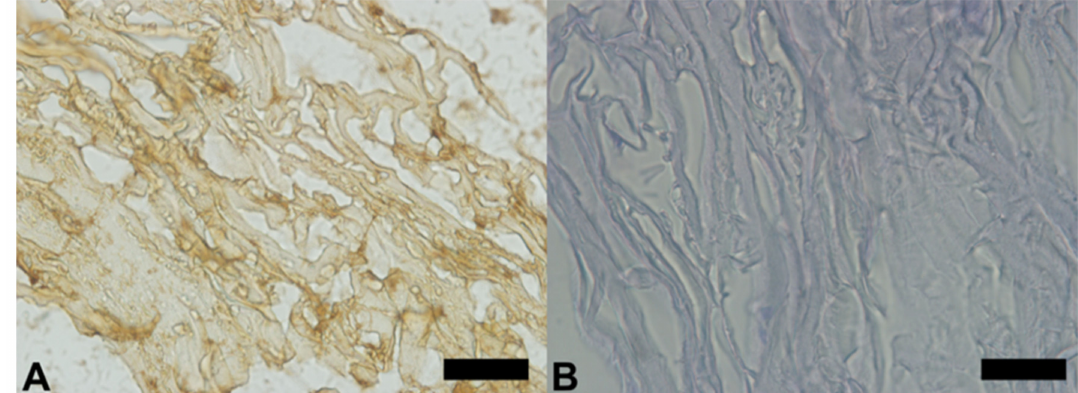
Figure 8. Morphology of membranes obtained in immunohistochemical analyses. ( A ) Type 1 collagen fibers extended throughout the sample, immunostained in brown, without the presence of other substances. ( B ) A negative control test, where there were no immune stains, certifying the efficiency of the process. Scale bar 100 µ m,